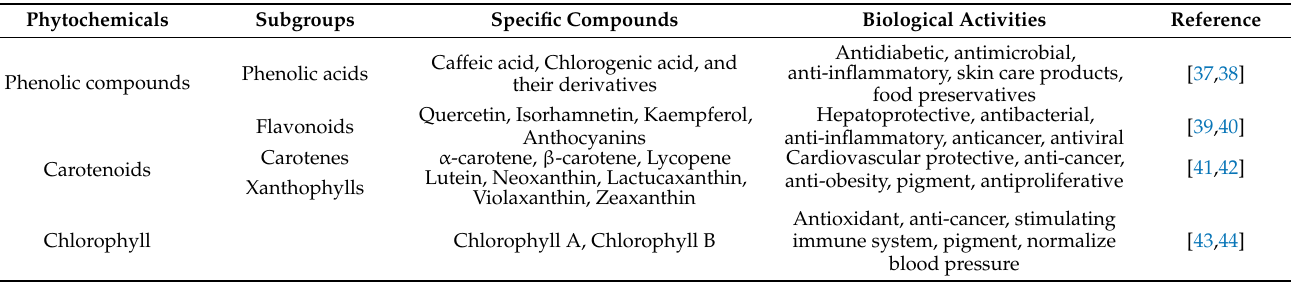
Table 1. Chemical structure of main phytochemicals identified in